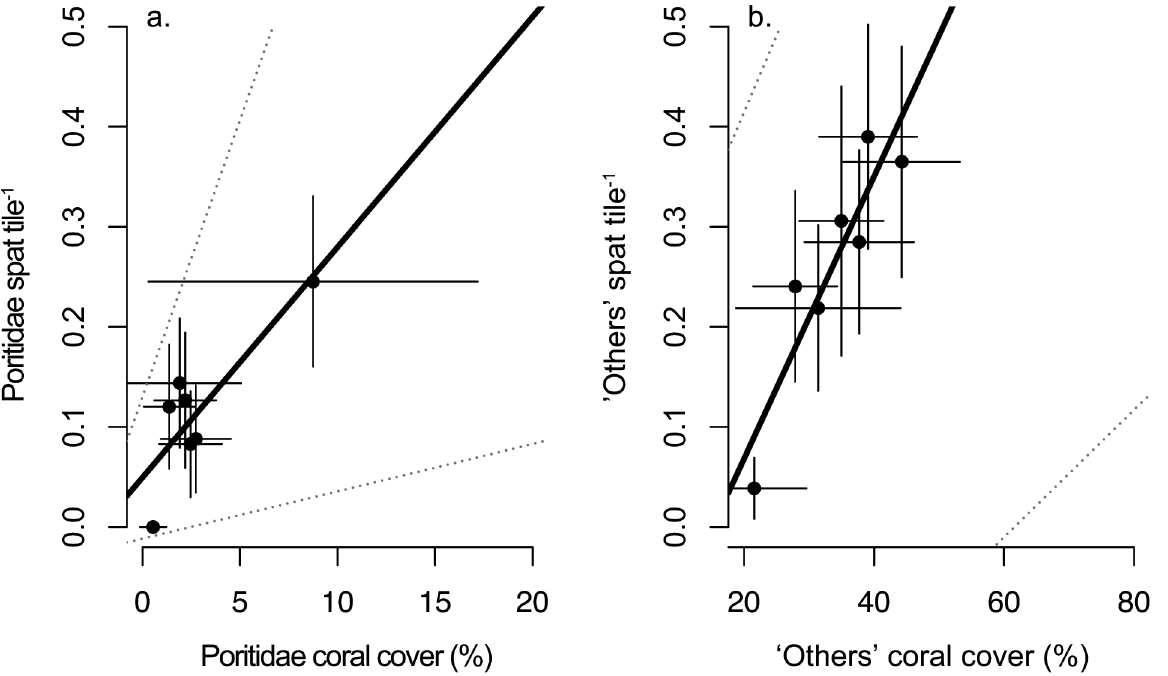
Fig 6. The relationship between adult coral cover and mean settlement over the entire study for a.) Poritidae and b.) ‘ others ’ . Error bars represent standard error. Dotted lines represent 95% confidence intervals from bootstrapped regression